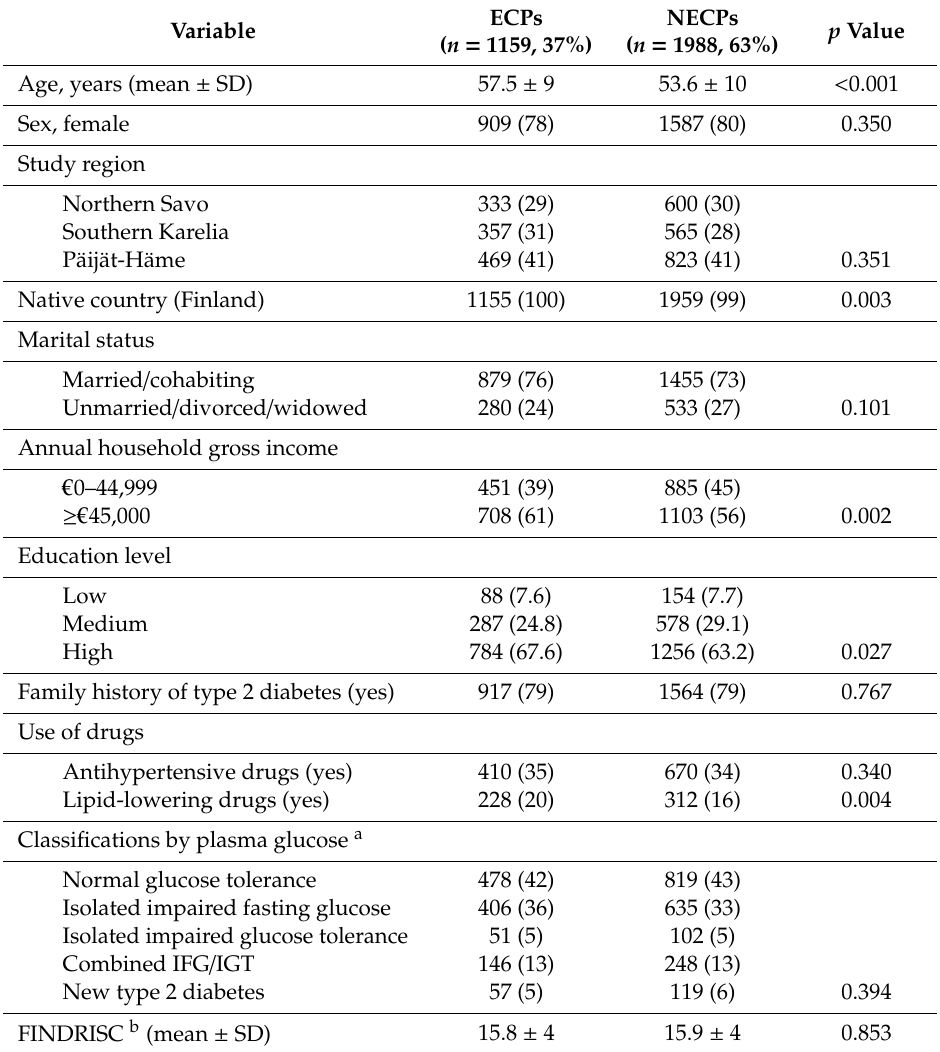
Table 1. Characteristics of eating competent participants (ECPs, ≥ 32 points) and not eating competent participants (NECPs, < 32